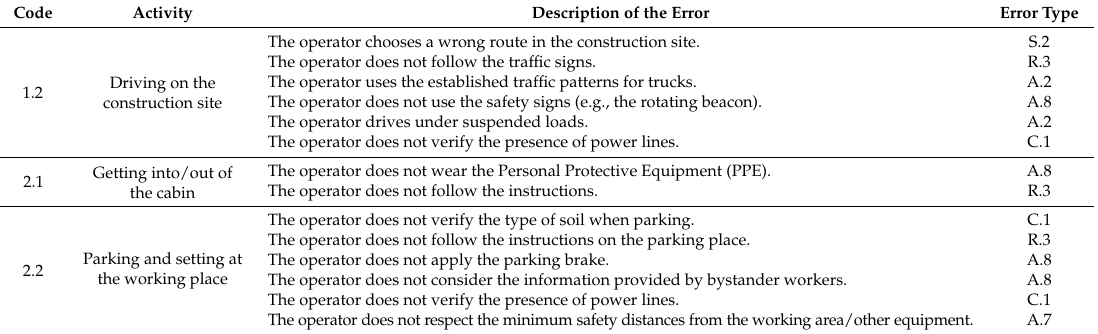
Table 2. Excerpt of the Predictive Human Error Analysis (PHEA/SHERPA)